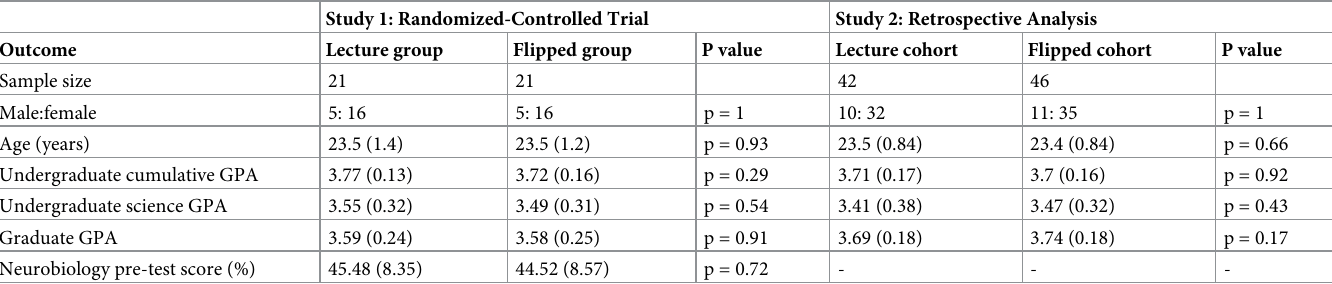
Table 2. Baseline Characteristics of RCT Cohort (Fall 2019).